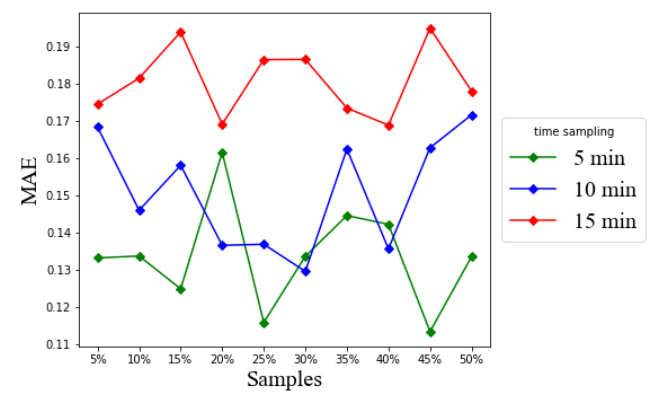
Figure 21. MAE with varied time